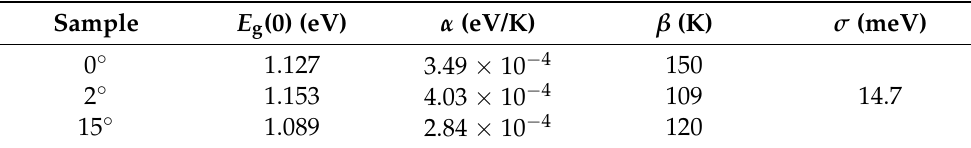
Figure 7. Temperature-dependent peak energies of the InGaAs/GaAsP QWs on ( a ) 0°, ( b ) 2°, and ( c ) 15°-misoriented substrates. Table 1. Fitting parameters, α , β , and σ , for the differently misoriented substrates.